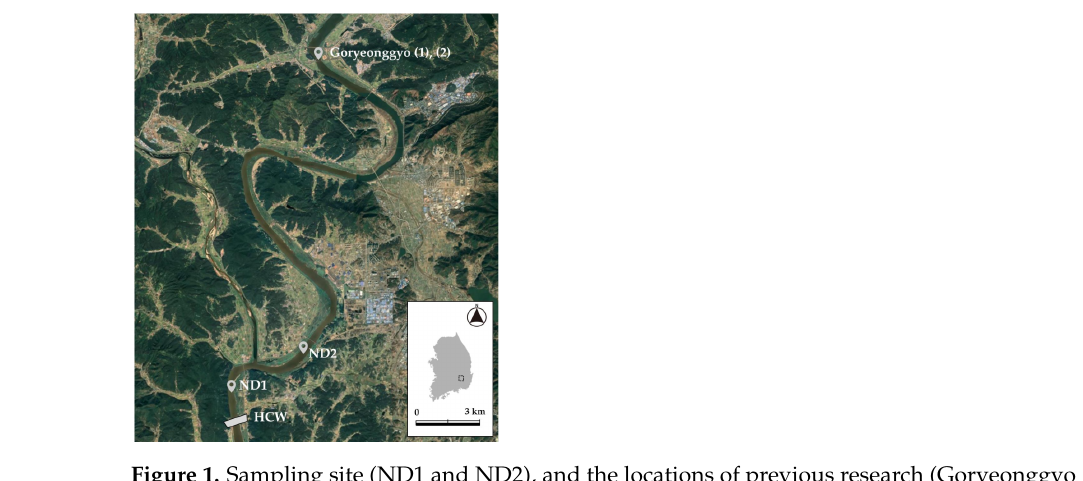
Figure 1. Sampling site (ND1 and ND2), and the locations of previous research (Goryeonggyo ( 1 ), ( 2 )) of heavy metals in the Nakdong